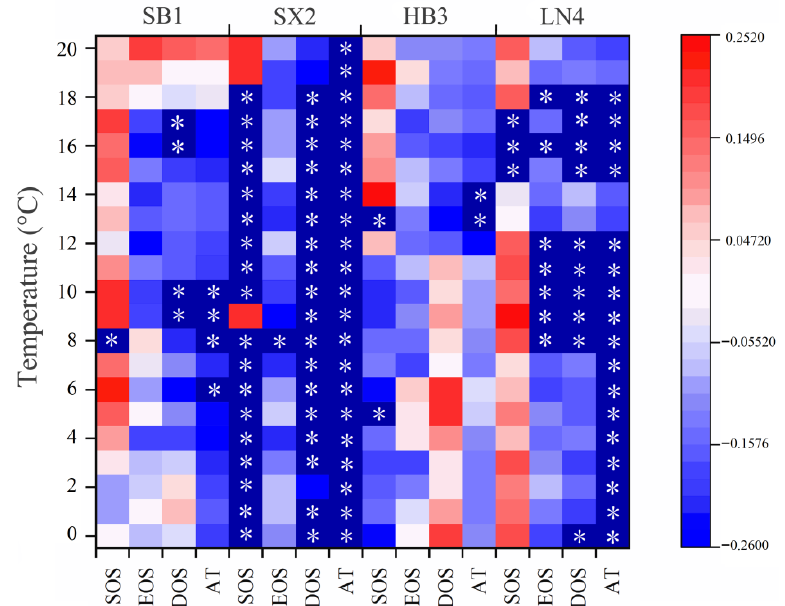
Figure 6. Correlations between tree-ring width series and the DOY series of onset date, cessation date, duration, and accumulated temperatures from each site and corresponding meteorological station.